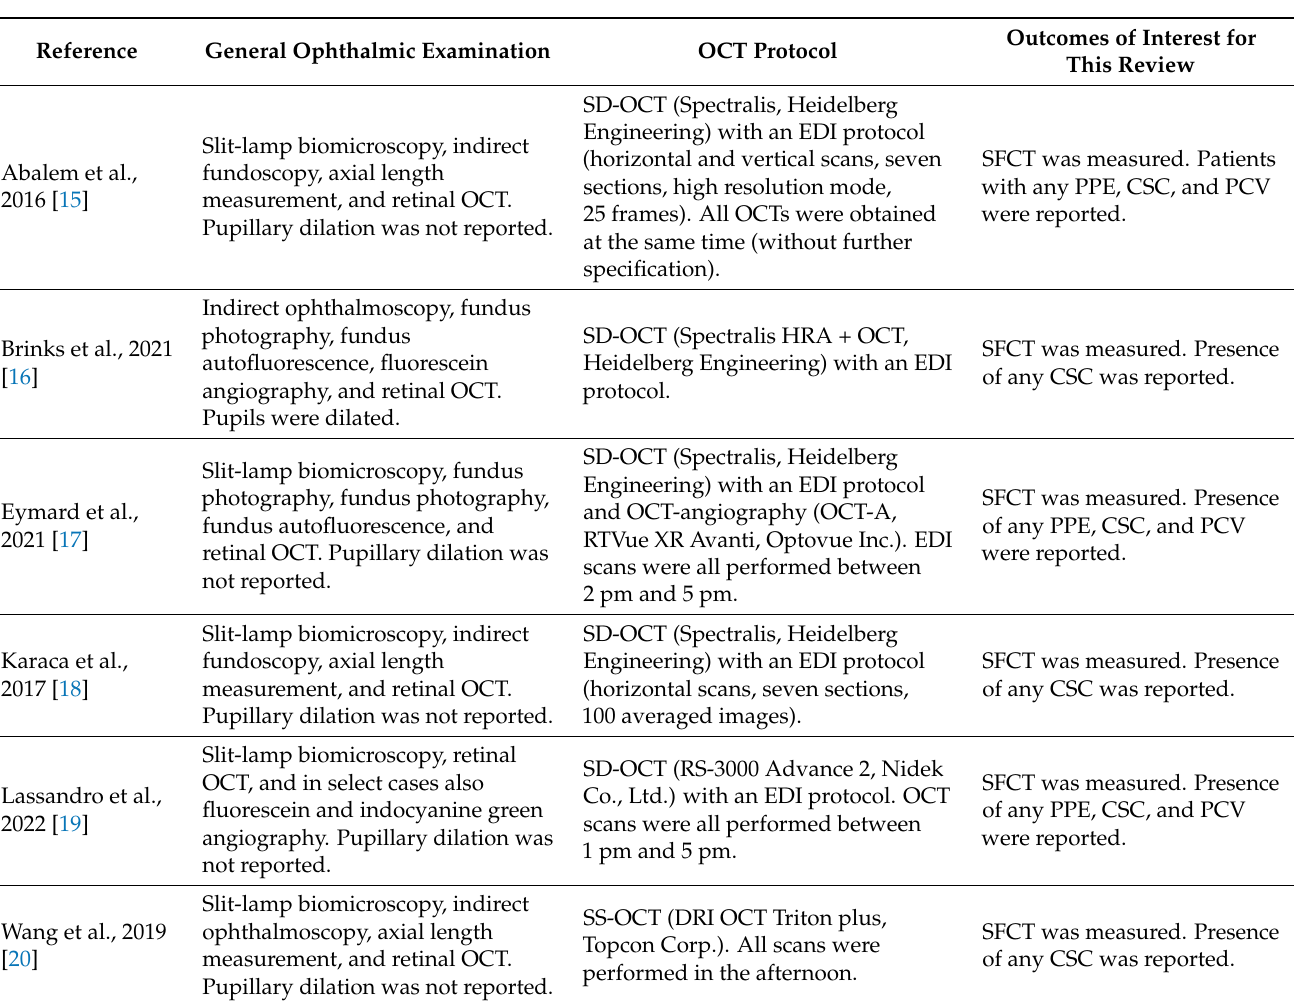
Table 2. Methods of ophthalmic examination.